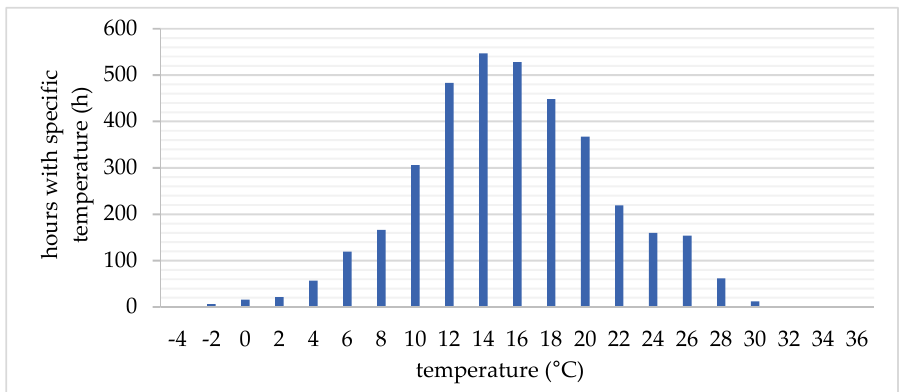
Figure 4. Histogram of the external air temperature distribution for the period of May from September according to the data by the typical meteorological year.